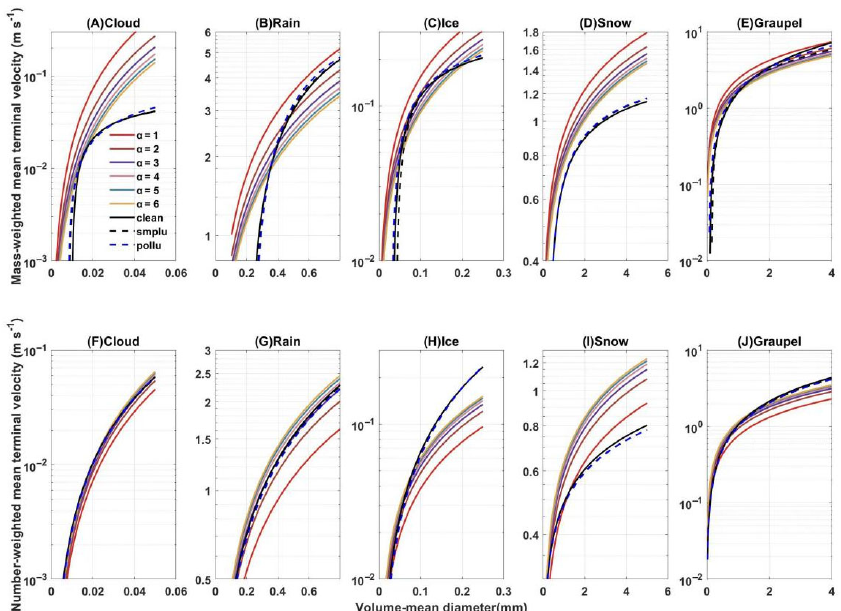
Figure 4. Mass-weighted (top) and number-weighted mean terminal velocity (below) of different hydrometeors as a function of volume-mean diameter when assuming the shape parameters as a different fixed value (colored solid line) and using clean (solid black line), moderate pollution (smplu, black dashed line), and polluted (pollu, blue dashed line) parametrizations: ( A , F ) cloud droplets, ( B , G ) raindrops, ( C , H ) ice crystals, ( D , I ) snow, and ( E , J ) graupel. Except for cloud droplets, parameterizations of other hydrometeors calculated using fixed α value will overestimate V m of small volume ‐ mean diameter particles, which may make small particles fall faster and reduce their relative speed, resulting in lower collision efficiency of large particles, delaying the onset of precipitation. For cloud droplets, param ‐ eterization of V m using a fixed α value will lead to overestimation for the entire size dis ‐ tribution, which is more significant for the droplets with larger volume ‐ mean diameter. This can increase the collection efficiency of large cloud droplets. To further explore the impact of the new parametrization of mean terminal velocity on the vertical structure of the microphysics, the convective system was simulated using the WRF model with the default Morrison scheme (Control) and the modified Morrison scheme with new parameterization of V m and V n (ParamV), respectively (Figure 5). The default Morrison scheme calculates V m and V n with shape parameter α = 3 of the cloud droplets and α = 1 of the other hydrometeor species. Considering that the simulation area is around the Marshall Islands in a tropical region, the ParamV test uses the terminal ve ‐ locity parameterizations obtained under clean condition. Based on the discussion in Fig ‐ ure 4, we can expect that the ParamV experiment predicts reduced V m and increased V n .